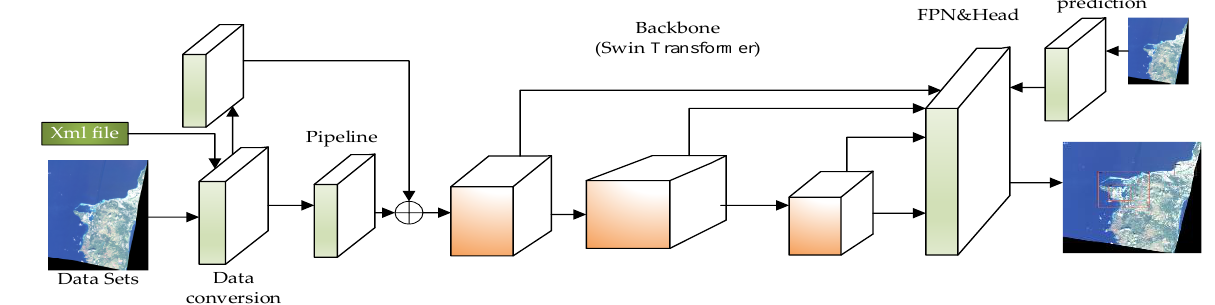
Figure 1. Swin-HSTPS model structure.